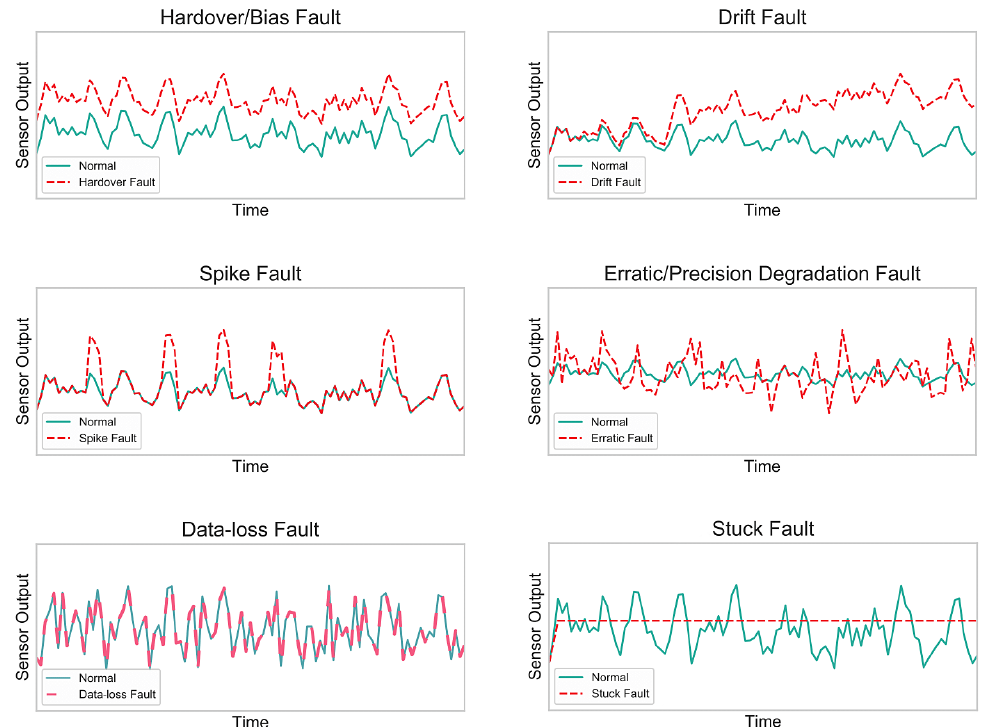
Figure 3. Normal/legitimate and faulty signal sample